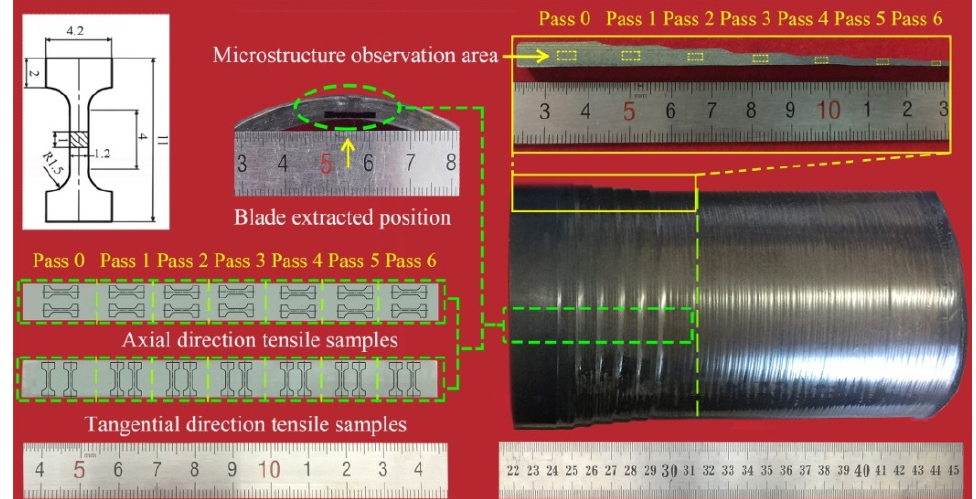
Figure 3. Preparation of microstructure and tensile specimen of axial and tangential direction.